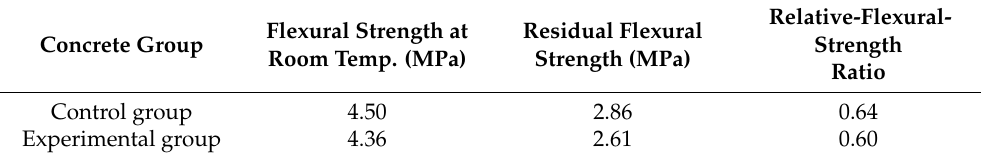
Table 21. Relative-flexural-strength ratio of the concrete after exposure to high temperature.